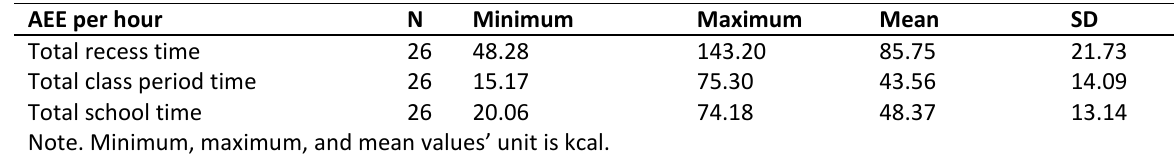
Table 3. Comparison of physical activity amounts between recess time (breaks) and other significant periods AEE per hour N